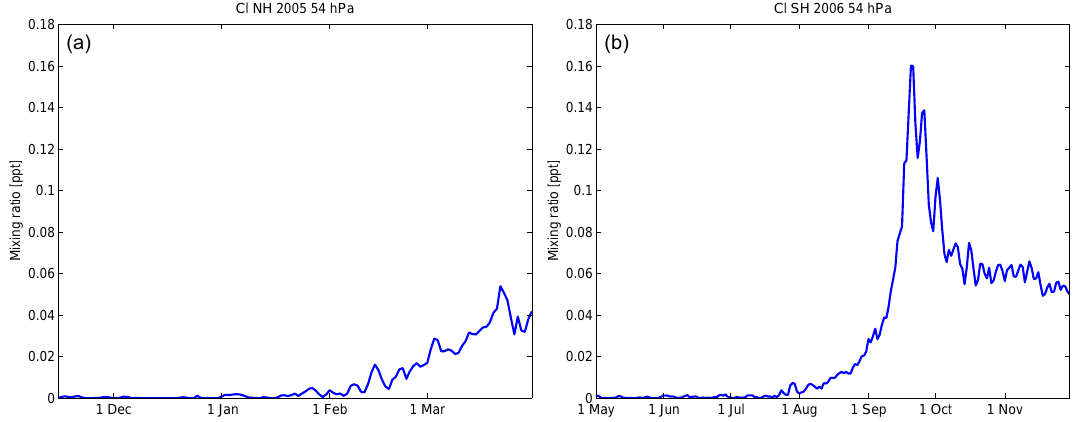
Figure 14. Vortex-averaged Cl mixing ratios for the Arctic winter 2004–2005 (a) and the Antarctic winter 2006 (b) at 54hPa.